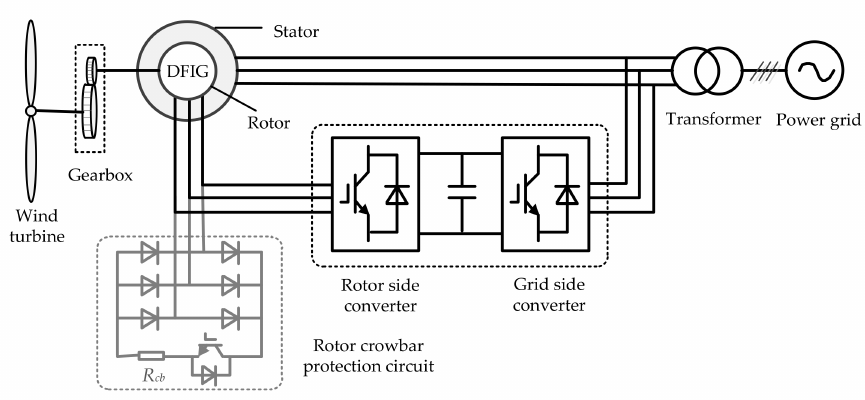
Figure 2. A typical DFIG with a rotor crowbar protection